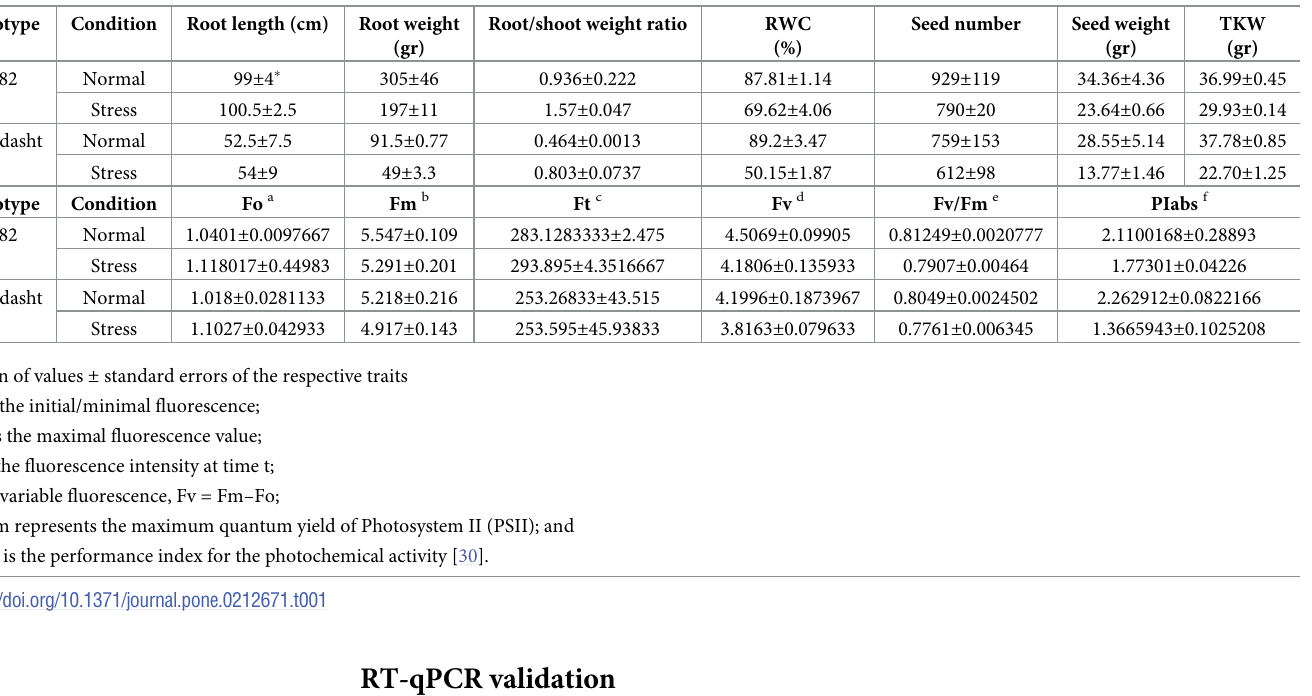
Table 1. Mean of morphological, physiological and seed yield-related traits of the evaluated genotypes under control and stress